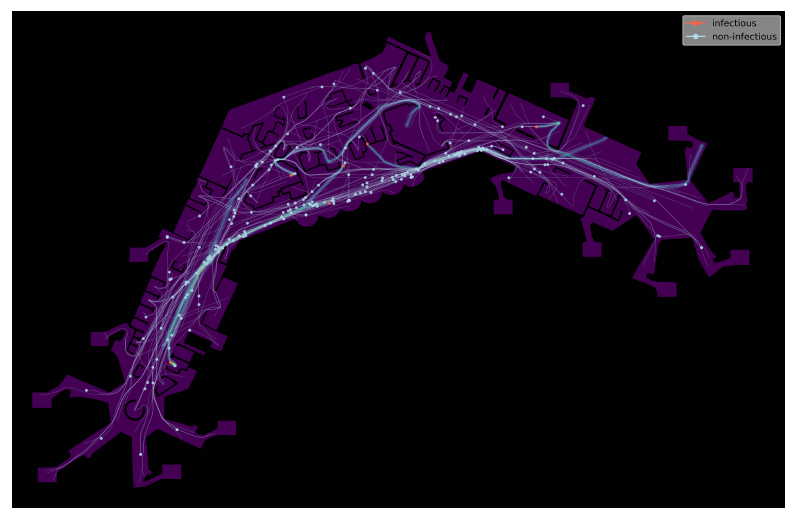
Figure 1. Visualisation of the developed agent-based simulation with agents, trajectories, and tracking of aerosols shown.